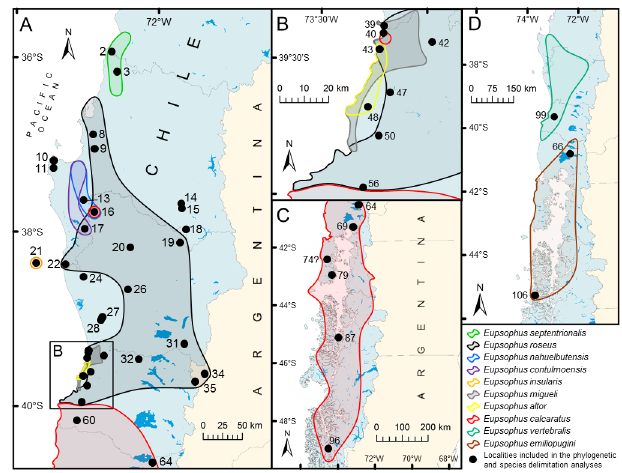
Fig 2. Schematic representation of distribution limits of Eupsophus spp. according to the literature. Shadedcoloredareas represent the distribution limits of the ten species of the genus (maps A, B, and C, roseus group; D, vertebralis group), which were obtainedjoiningthe records compiledfrom the literature(S5 File). These areas are not intended to depict the real distribution ranges, but only to show the describedlimits and degreeof overlapping among species, mainly in Chile, where the greatest diversity of species is found (see detailsin S4 File). Inversely, zones not coveredby the shadedareas do not mean the absenceof the genus, but just the lack of publishedrecords. Note the high degreeof overlappingamongspecies around37˚ 50’S (Nahuelbuta Range, localities16 and 17 of map A) and in the coastal area between39˚22’and 39˚52’S (map B), where even two isolatedlocalitiesof E . calcaratus are found (red shaded circles). Only the localities includedin the phylogenetic/delimitation analysesare indicated(black circles), and for Argentina,only the two localities of E . roseus of Blotto et al. [18] includedin these analyseswere considered. Thin gray lines within Chilerepresent boundariesof Administrative Regions.